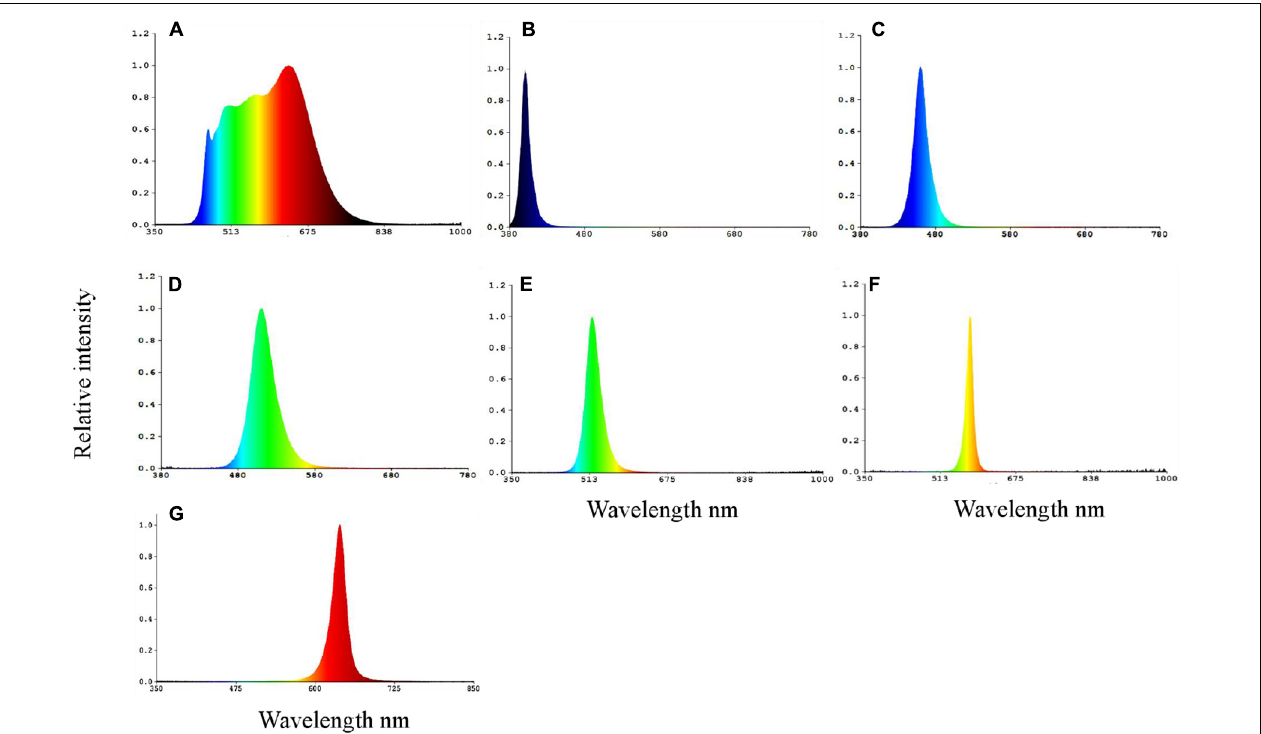
FIGURE 1 | The spectral composition of full-spectrum (A) , violet (B) , blue (C) , cyan (D) , green (E) , yellow (F) , and red (G) spectra LEDs on the water